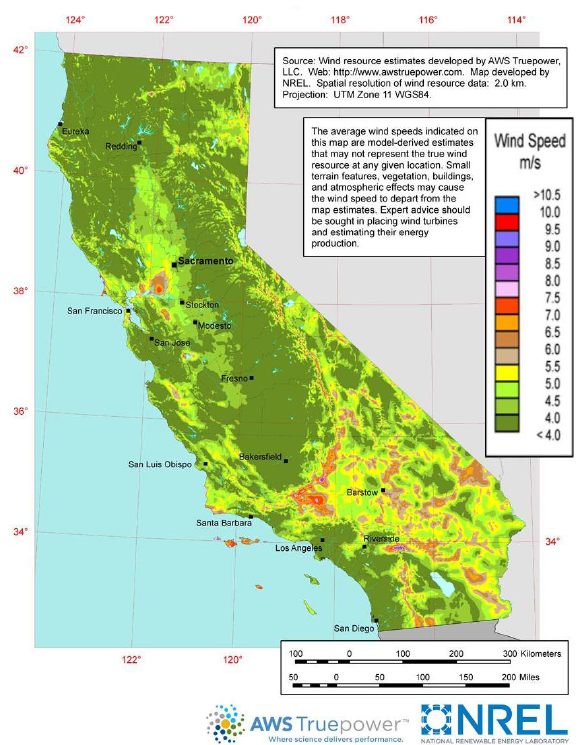
Figure 2. Annual average wind speed of California at 30 m